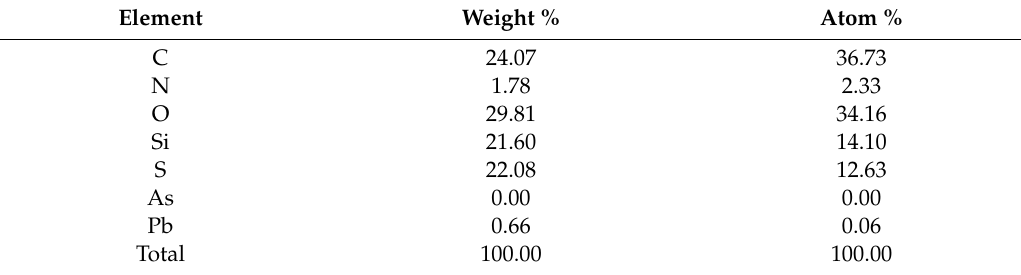
Table 2. (EDX) data of adsorbent 1 after